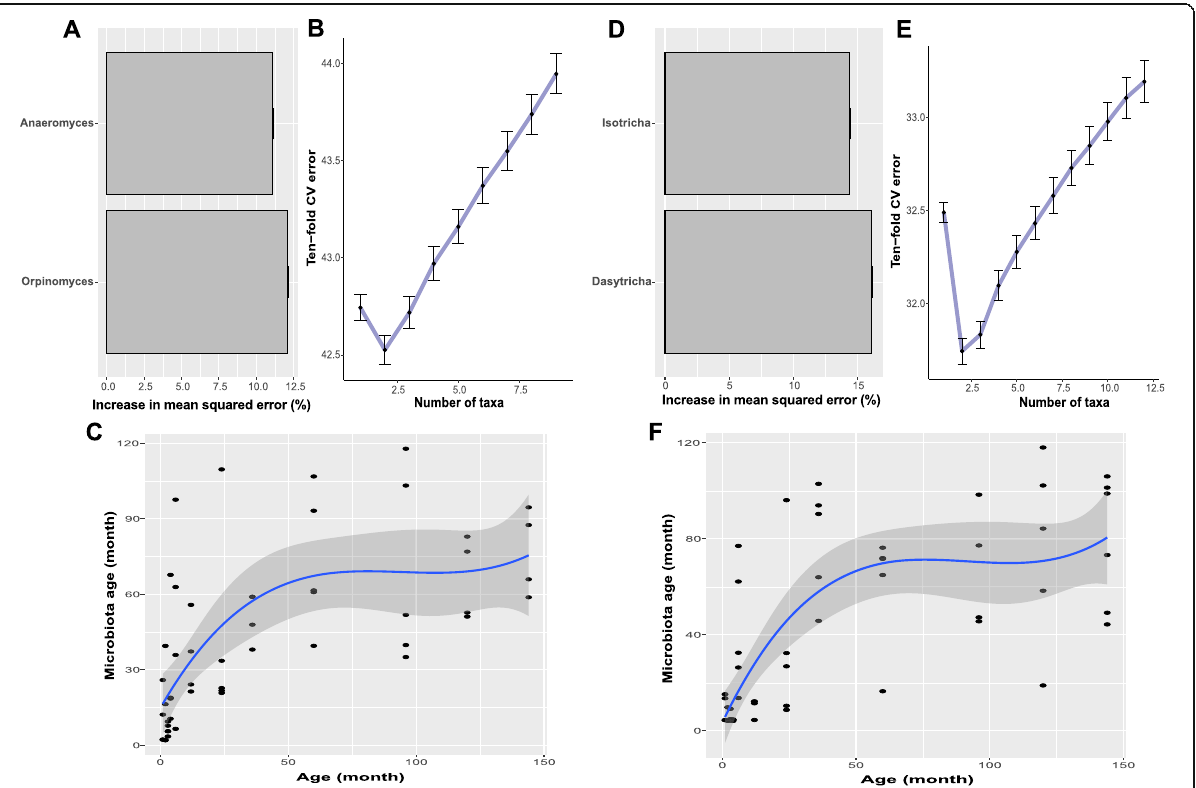
Fig. 5 Fungal and protozoal taxonomic biomarkers for defining rumen microbiota maturation in grazing yaks. a, d Age-discriminatory taxa were identified by applying random forest regression of the relative abundances of taxa in rumen fluid against chronological age of grazing yaks. Importance was determined based on the percentage increase in the mean-squared error of the predicted microbiota age when the relative abundance values of each taxon were randomly permuted (mean importance ± sem., n = 100 replicates). b, e The 10-fold cross-validation error as a function of the number of input taxa used to regress against the age of yaks in the training set, in order of variable importance. c, f Microbiota age predictions plotted against chronological age. The curve is a smoothed spline fit between microbiota age and chronological